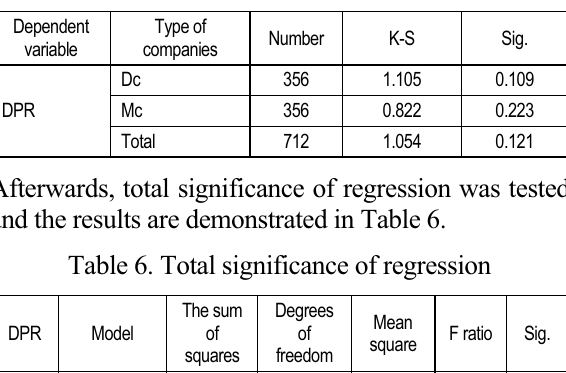
Table 5. Results of the Kolmogorov-Smirnov test